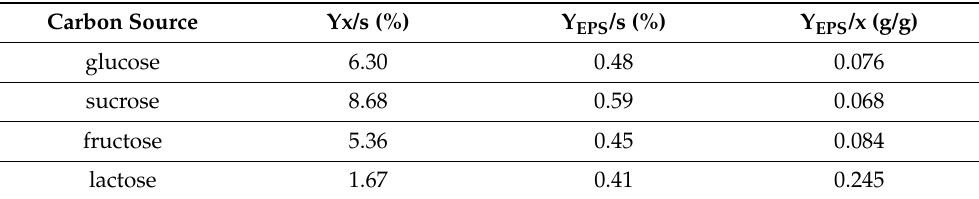
Table 1. Effect of different carbon sources on the total yield of mycelial biomass and polysaccharides production from T. borchii submerged